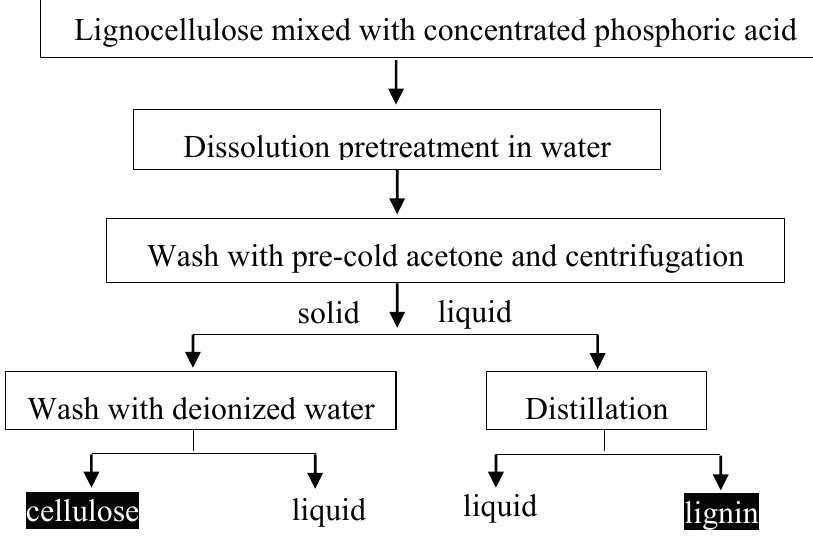
Figure 1. The phosphoric acid–acetone pretreatment